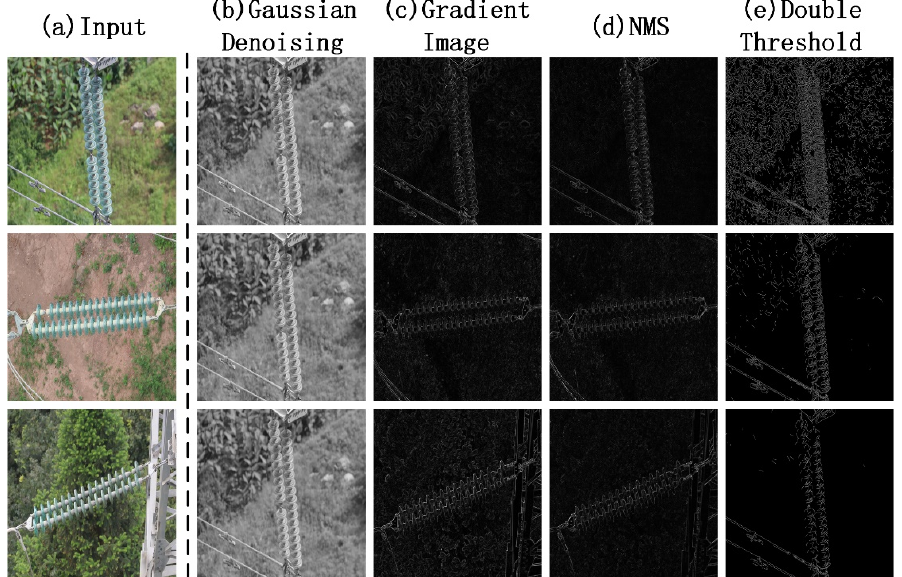
Figure 4. Test examples of image augment. ( a ) The original input, ( b ) the Gaussian denoising comparison of the same image, ( c ) the gradient image, ( d ) the image after NMS processing, and ( e ) the edge image obtained by the double-threshold segmentation method.